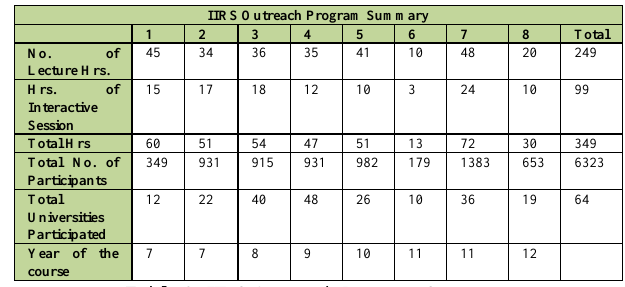
Table 6: IIRS Outreach Program Summary